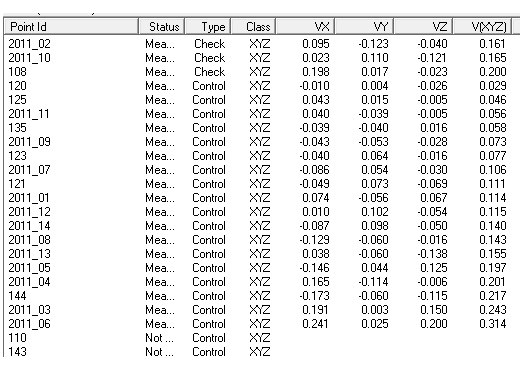
Table 2. Bundle Adjustment + EO + Control